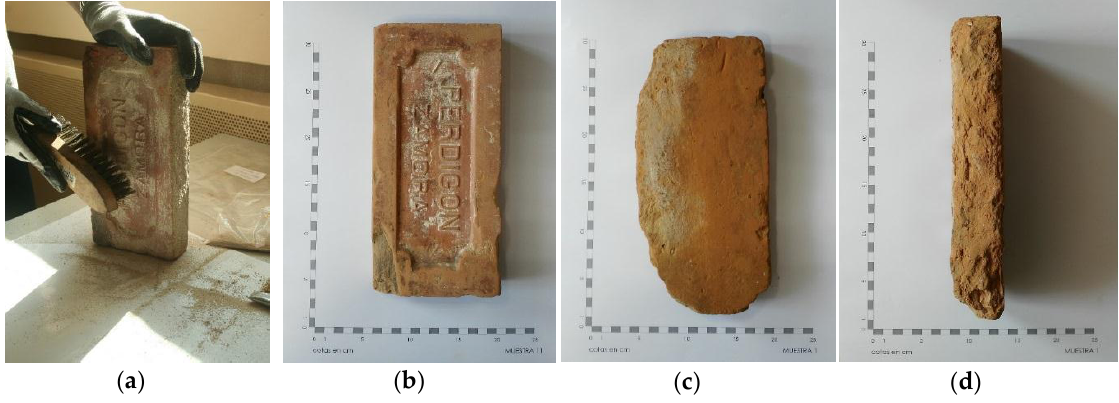
Figure 2. Brick cleaning treatment ( a ) and cataloguing ( b – d ).